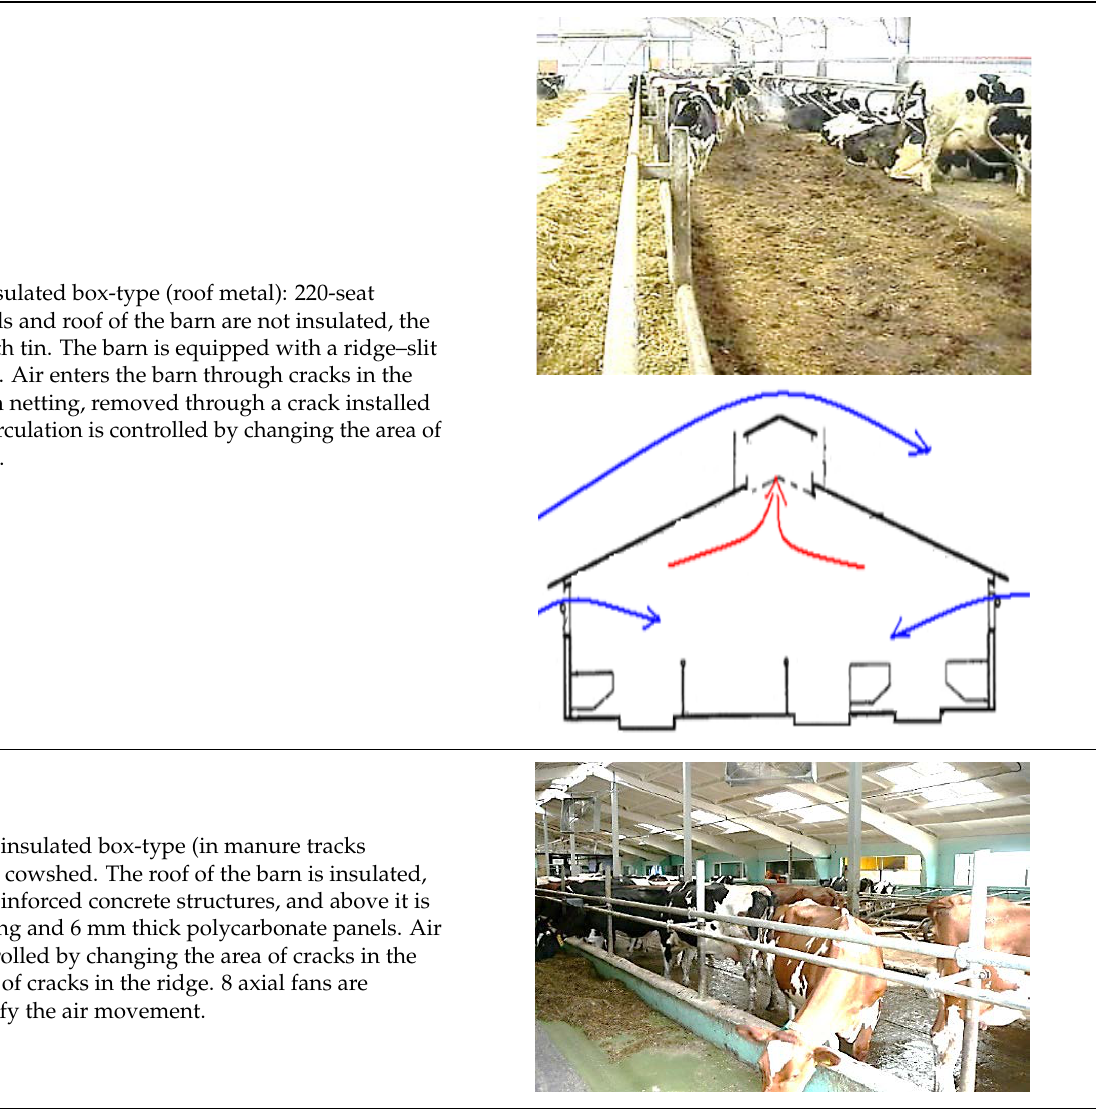
Table 1. Experimental microclimate research performed in the most popular cowsheds in Lithuania